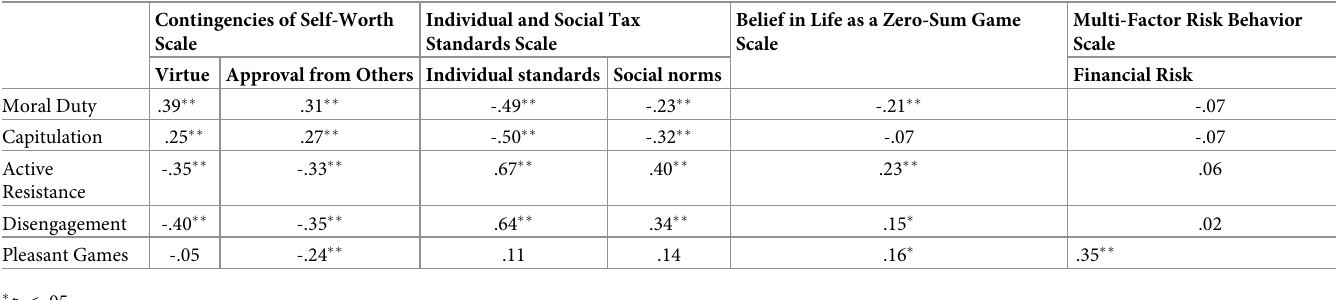
Table 4. Pearson’s r coefficients for relationships between scores on the five Polish MPQ scales and scores on the four validation instruments. Contingencies of Self-Worth